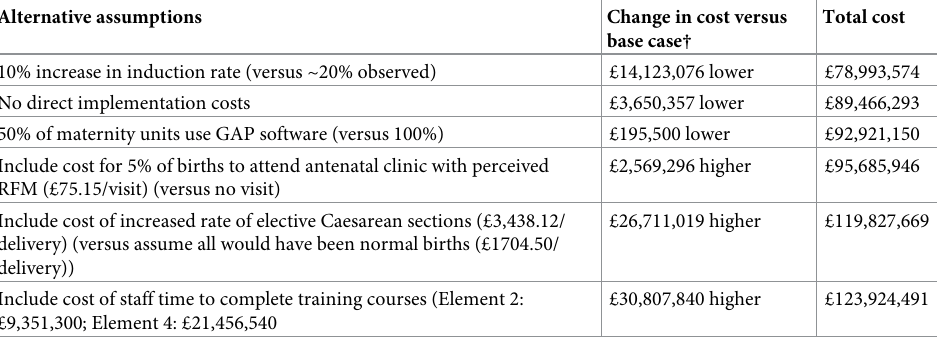
Table 6. Alternative assumptions for costs associated with the SBL care bundle (total costs across the whole of